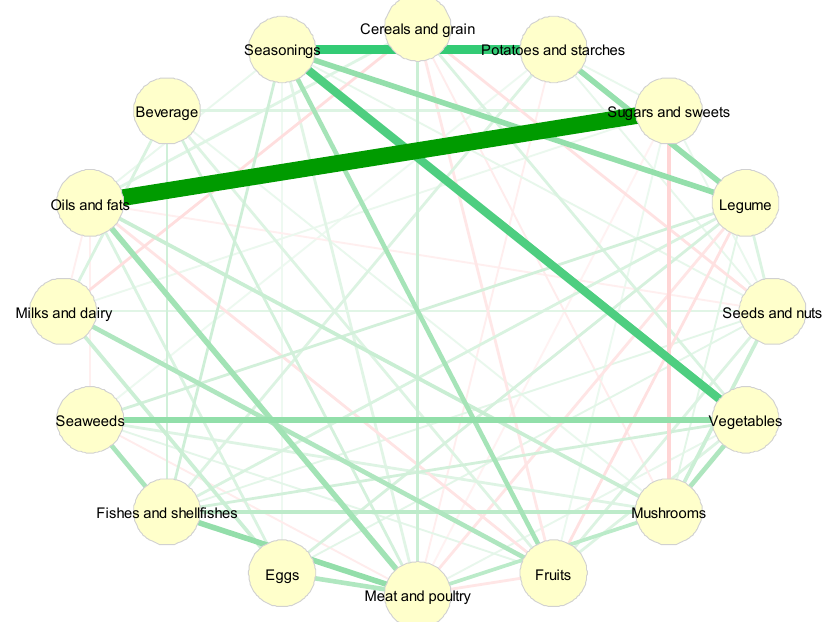
Figure 2. Network of dietary intake derived by Gaussian graphical models.